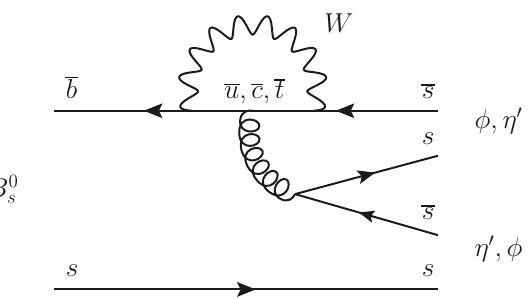
Figure 1 . Lowest-order diagrams for the B 0